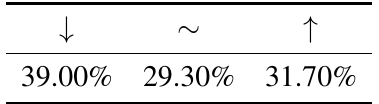
Table 1. The empirical probabilities of I ( ↑ / ↓ ) over the period